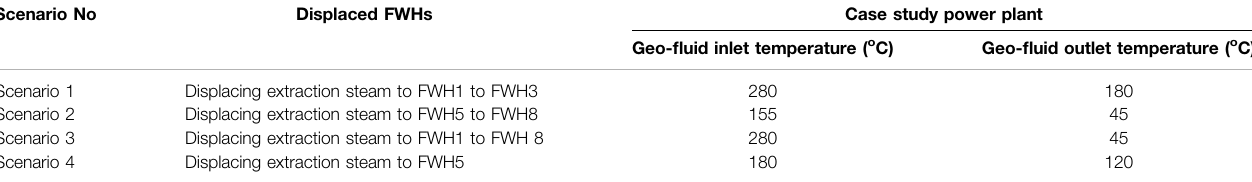
TABLE 3 | Case study